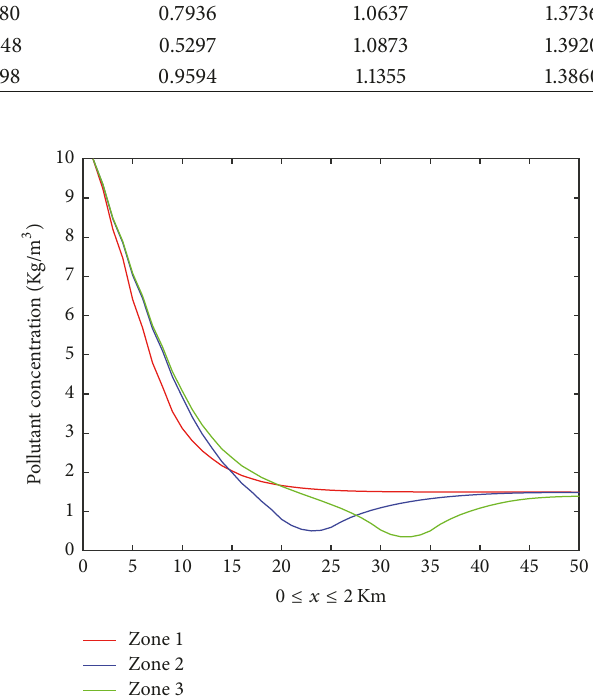
Figure 11: Comparison of approximated pollutant concentrations alongthemiddlepart, 𝐶(𝑥, 𝑦,𝑡) ,forall 0 ≤ 𝑥 ≤ 2000 m, 𝑦 = 1000 m, and 0 ≤ 𝑡 ≤ 100 min, when the first, second, and third zonal removal mechanism systems are